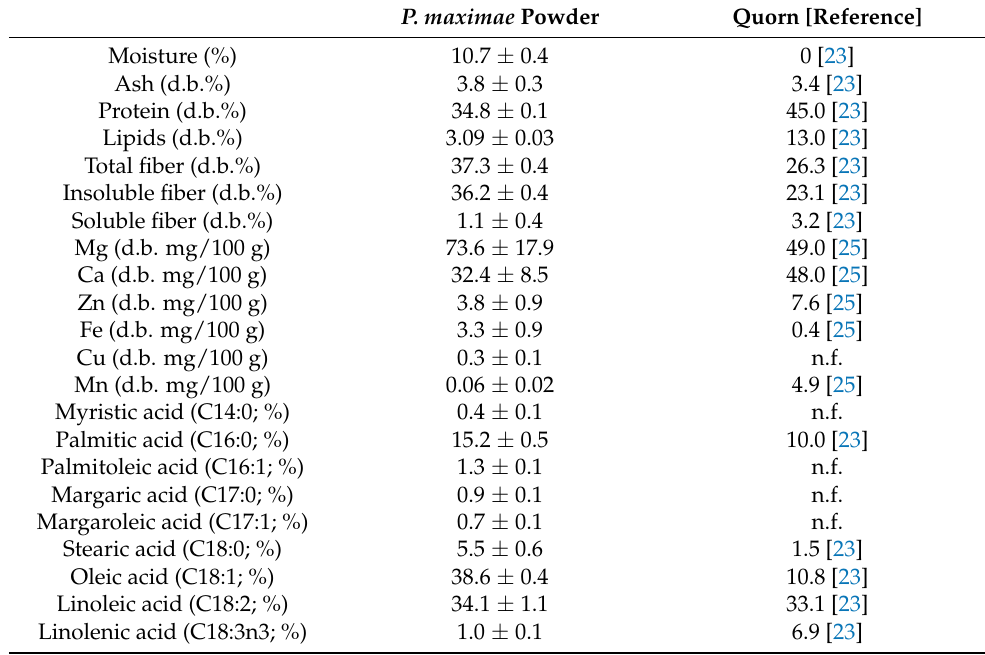
Table 1. Nutritional composition of P. maximae biomass powder compared to mycoprotein data.